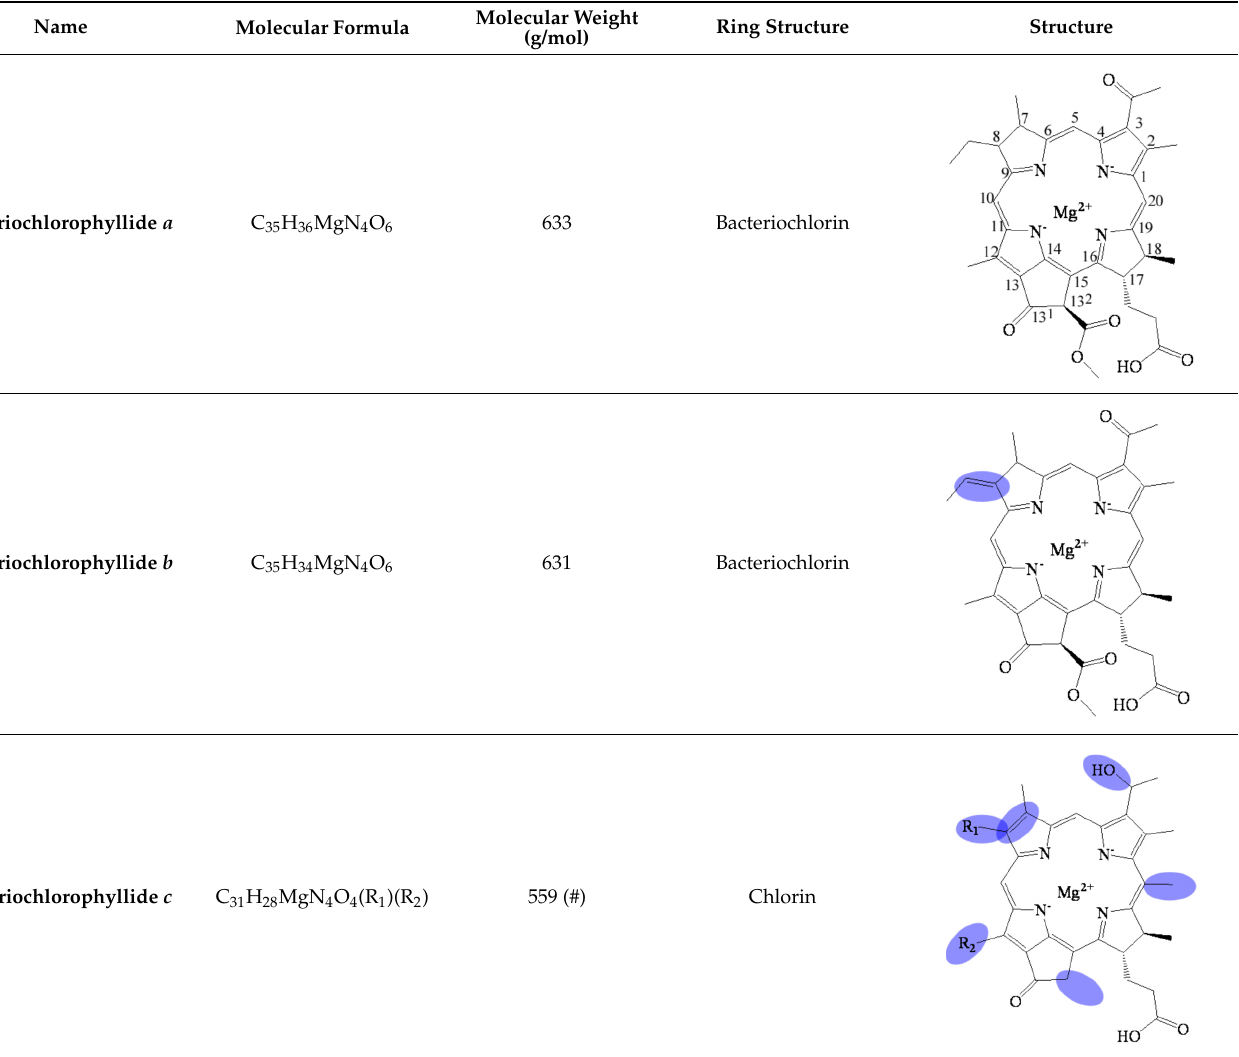
Table 1. The molecular formula, molecular weight and structure of